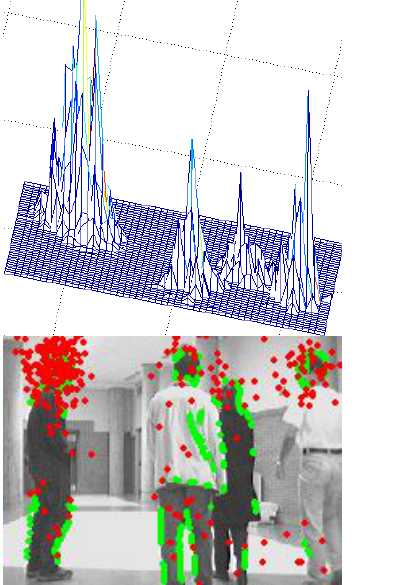
Figure 11. Results of the multi-tracking process in a real experiment: left column shows the results generated by the XPFCP; the right column shows the results of the proposal presented in